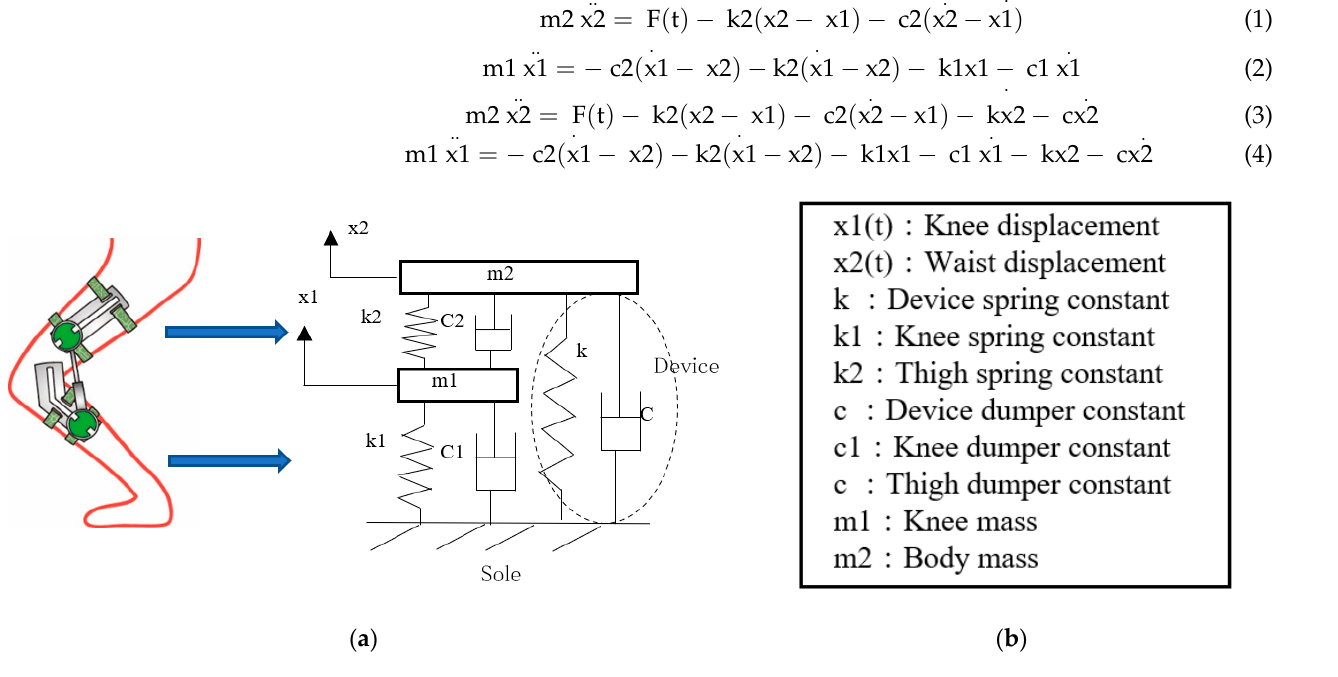
as (1) and (2), where F(t) is the external force. Equations (3) and (4) are also obtained by including the device.